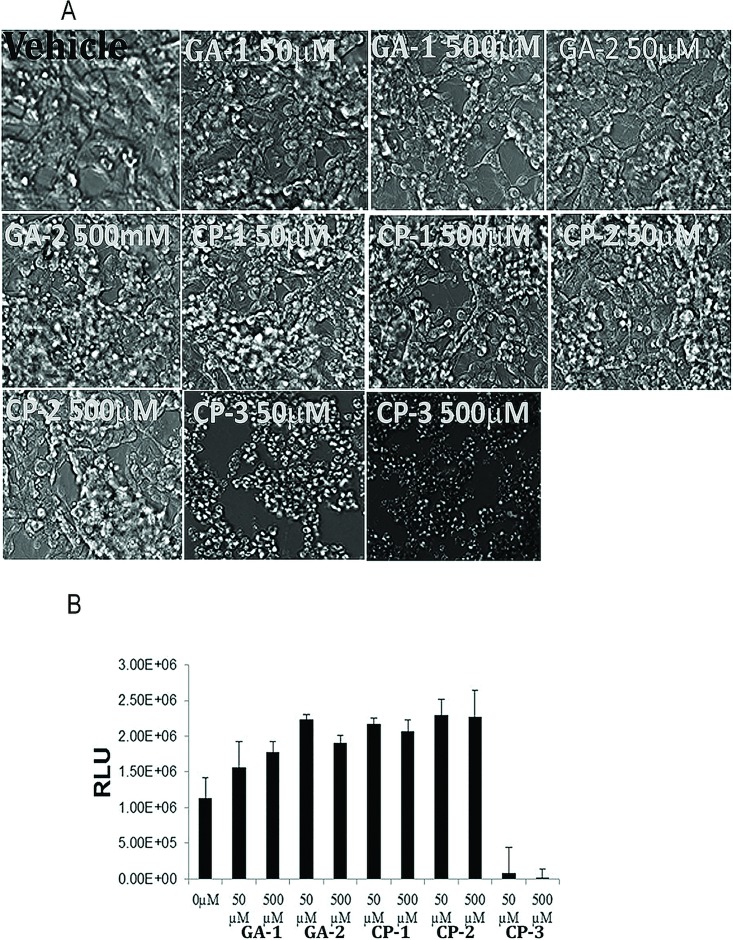
Effect of GILZ analog (GA) on cellular morphology and metabolic activity in neuroblasts: Differentiated SK-N-SH neuroblastoma cultures were exposed to individual GA or control peptide (CP) at the indicated concentration for 24h.(A) Phase contrast imaging of the cells shows no apparent adverse effects on morphology of cells exposed to GA-1 or GA-2 or CP-1 or CP-2 at either concentration. Exposure to CP-3 at both concentrations showed morphological changes consistent with cell death. (B) Cell lysates were assessed by CTG assay to determine relative levels of intracellular ATP. An increase in Relative Luminescence Units (RLU) suggesting cellular viability was observed with all treatments except CP-3. Data represent average+/-SD from three experiments.